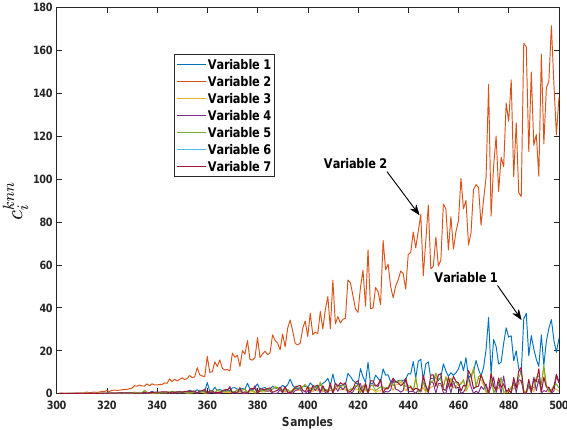
Figure 9. The variable contribution by kNN for case 3 of numerical